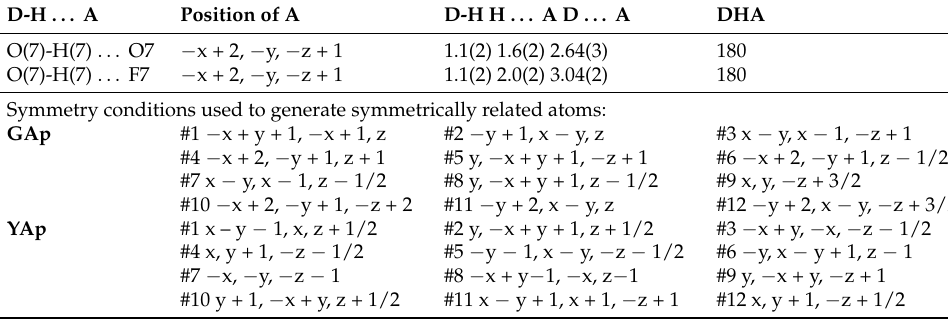
Table A6. Geometry of hydrogen bonds in GAp [Å, ◦